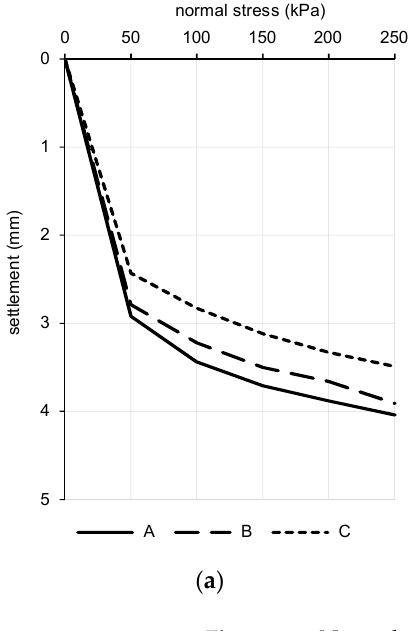
Figure 14. Normal stress-steady settlement relation for oedometer tests for samples A, B and C. ( a ) Original sample; ( b ) Boiled sample.